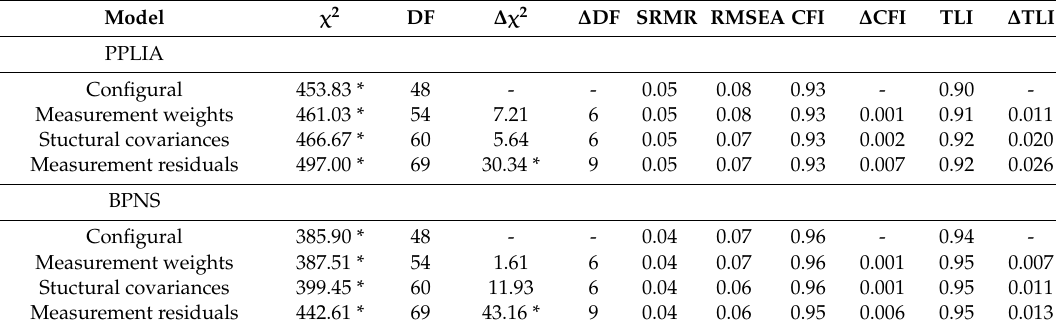
Table 2. Model fit of various invariance